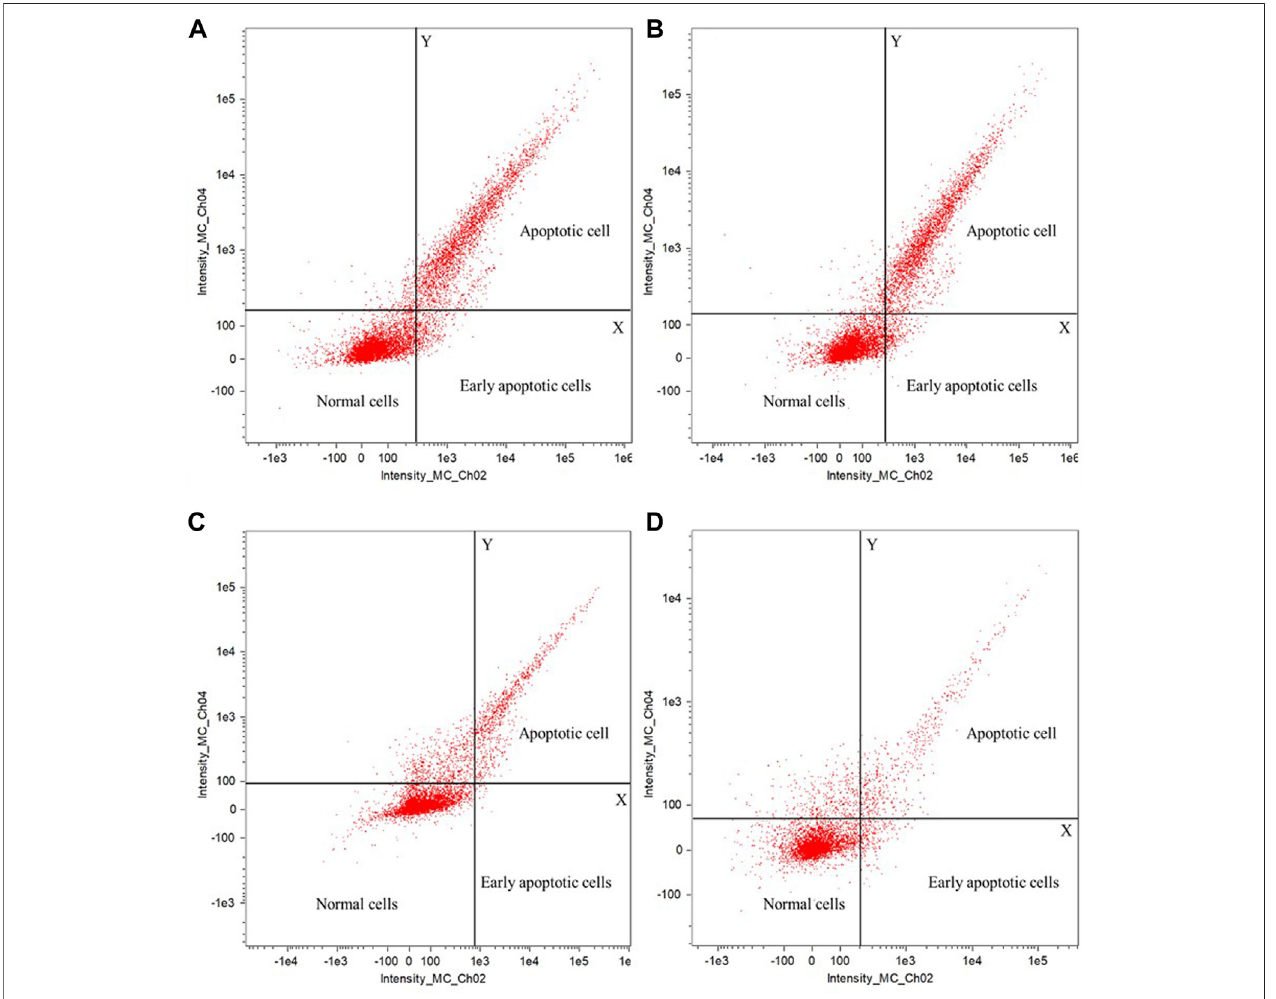
FIGURE 5 | Effect of sweet sorghum polyphenols on apoptosis of pathogenic bacteria (A) is Staphylococcus aureus (B) is Listeria spp (C) is Escherichia coli , and (D) is Salmonella spp.In thecoordinate systemofthe fi gure,the fi rst quadrant contains apoptotic cells,the thirdquadrant contains normalcells, and thefourth quadrant contains early apoptosis